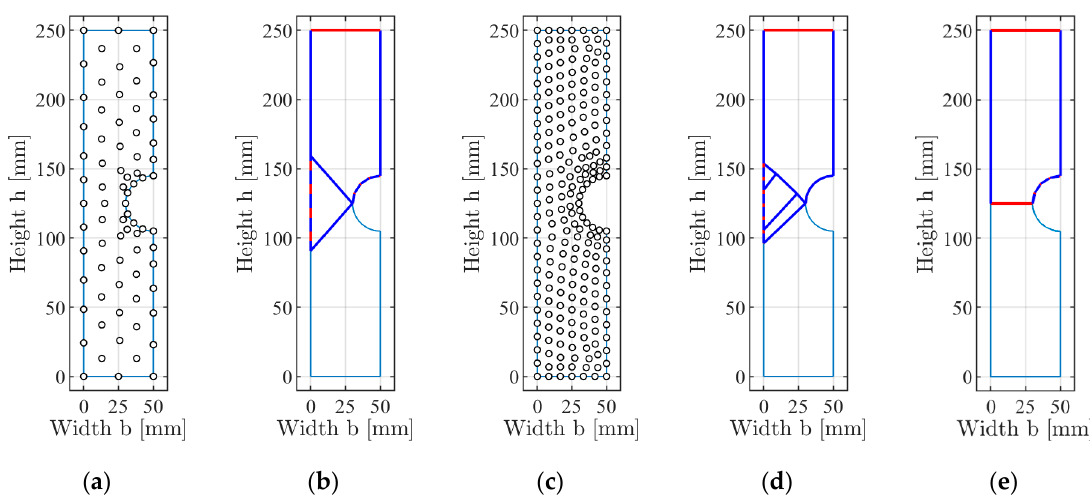
Figure 7. Collapse mechanisms (blue: Slip displacements, red: Normal displacements) from DLO for the tensile specimen with a hole (only the left side of the symmetry model is shown): ( a ) Nodes; ( b ) slip line mechanism; ( c ) refined node distribution; ( d ) refined slip line mechanism, ( e ) yield zone mechanism.